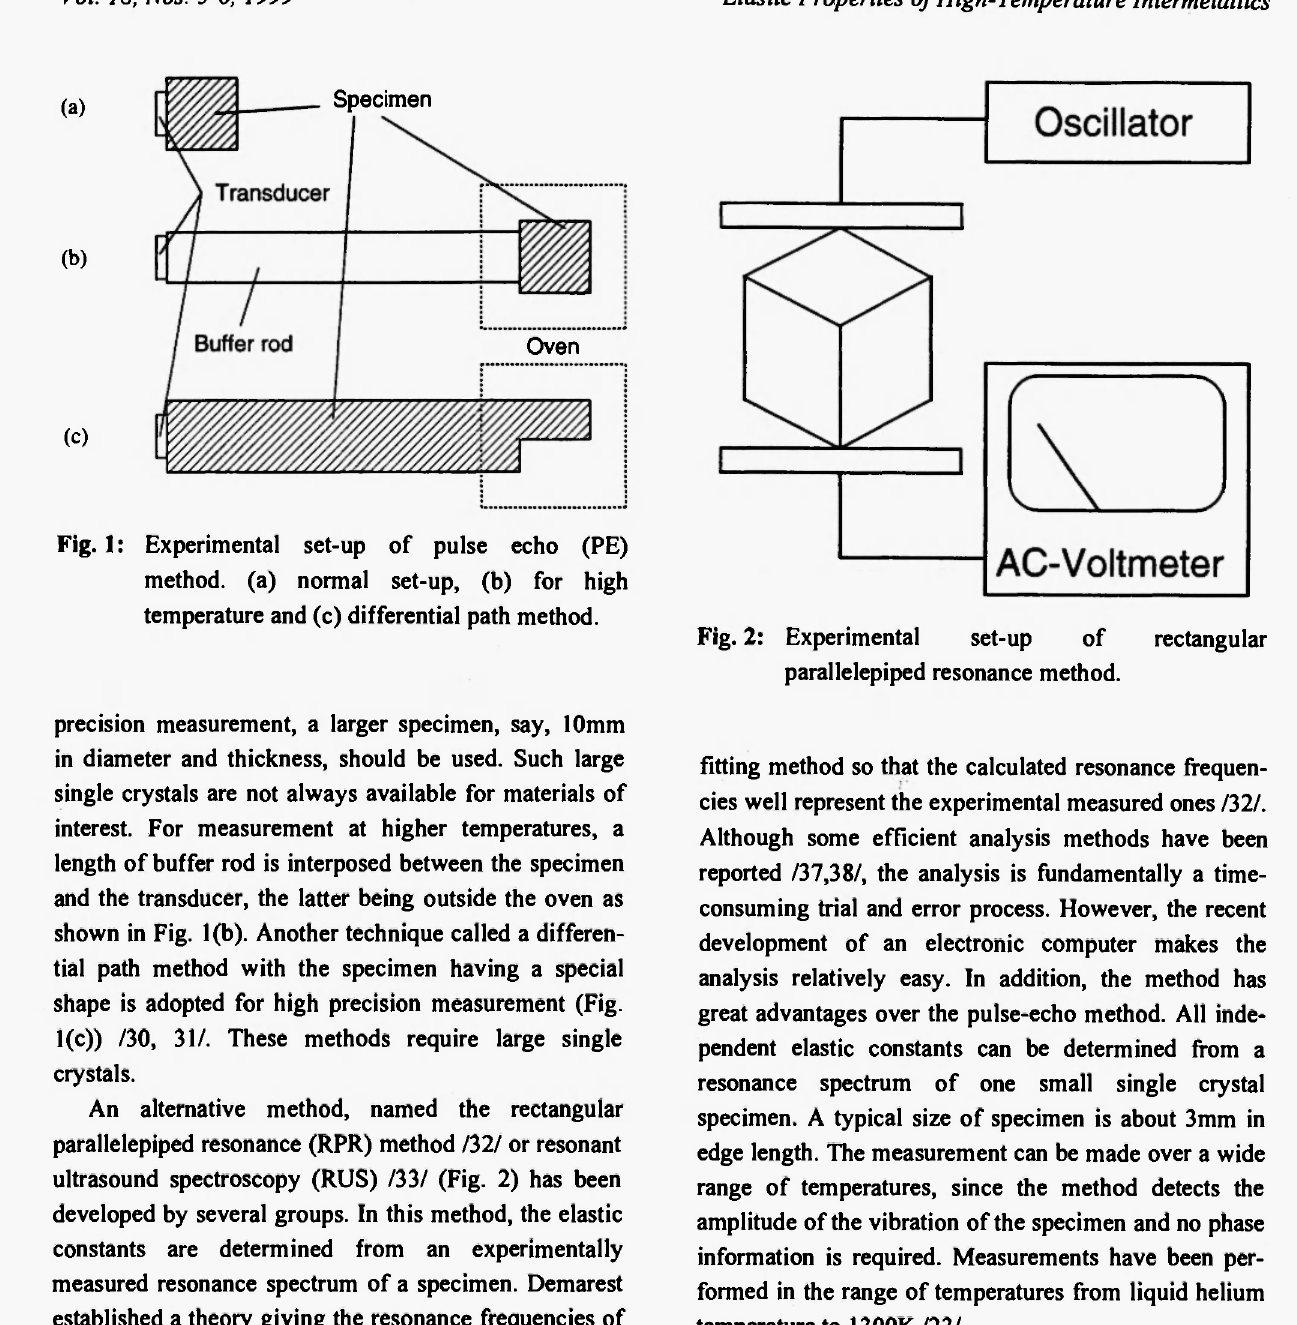
Fig. 1: Experimental set-up of pulse echo (PE) method, (a) normal set-up, (b) for high temperature and (c) differential path method.